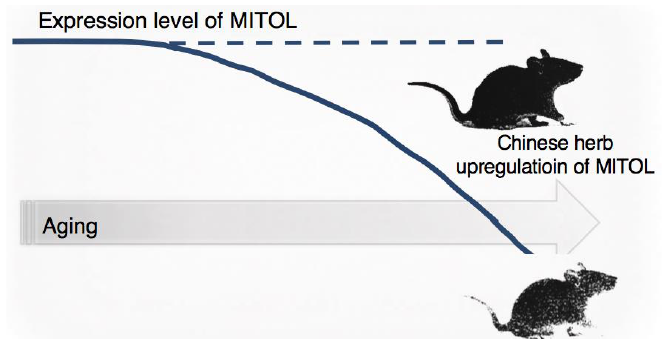
Figure 2. Relativity between MITOL and aging. Since MITOL gradually decrease following aging, upregulation of MITOL by a Chinese herb might be able to effect anti-aging.